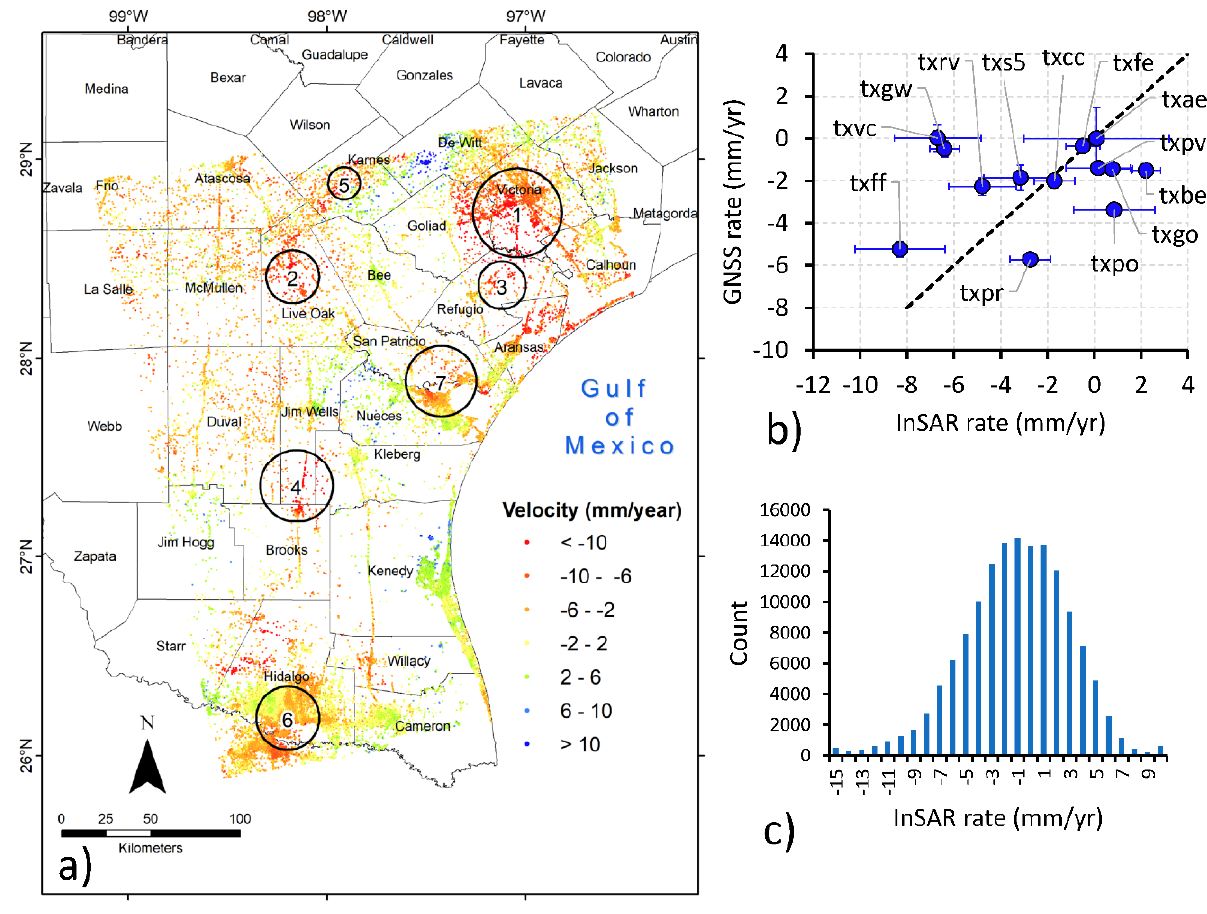
Figure 6. ( a ) InSAR-derived land subsidence rates (vertical component; in mm/yr) generated over the Texas Coastal Bend during the period from October 2016 to July 2019. ( b ) Correlation of InSAR-derived and GNSS-derived land deformation rates ( R : 0.24). The dashed line represents the 1:1 line. (c) Histogram of InSAR-derived land deformation rates.